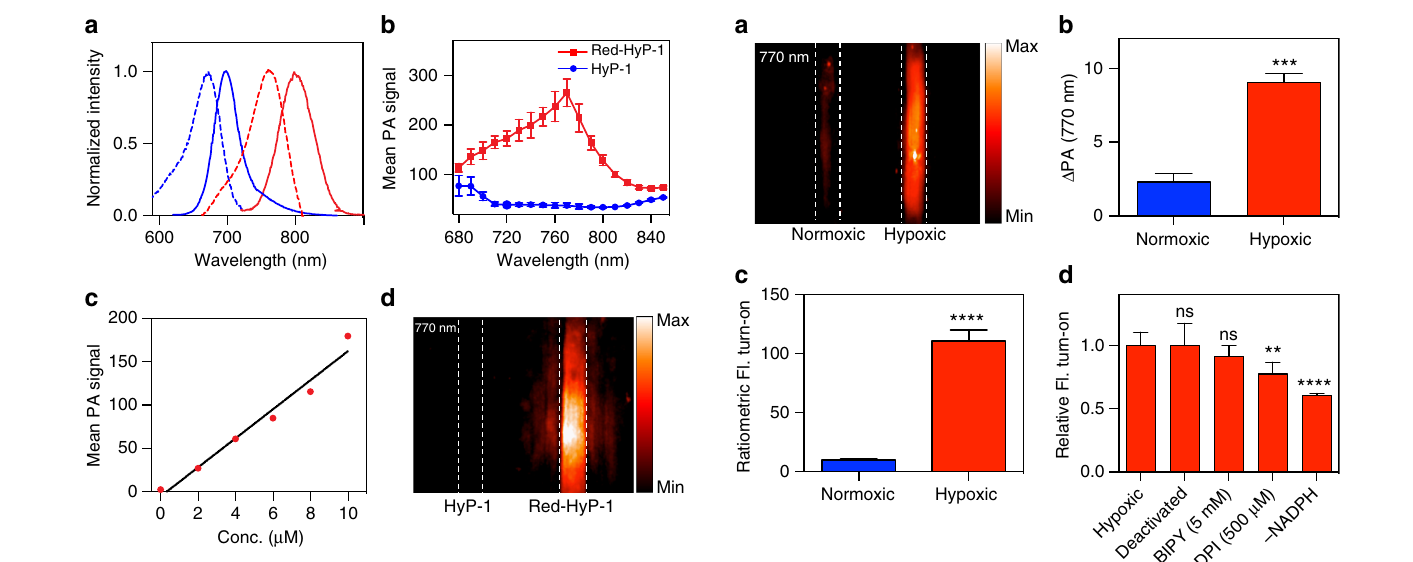
Fig. 4 Hypoxia-selective response of HyP-1 in vitro. a Representative PA image (770 nm) of reaction mixtures incubated under normoxic or hypoxic conditions for 2 h, then quenched with an equal volume of acetonitrile. Dashed lines indicate positioning of FEP tubes. b Change in PA signal (770 nm) produced after 2 h incubation of HyP-1 (10 μ M) with rat liver microsomes (RLM) (200 μ g/mL) and NADPH (50 μ M) in normoxic and hypoxic conditions ( n = 3). c Ratiometric fl uorescence turn-on after 2 h incubation of HyP-1 (2 μ M) with RLM (200 μ g/mL) and NADPH (50 μ M) in normoxic or hypoxic conditions ( n = 3). d Normalized fl uorescent turn-on after 1 h hypoxic incubation of HyP-1 (2 μ M) with RLM (100 μ g/mL) and NADPH (50 μ M) under various conditions. Statistical signi fi cance represents a comparison to the hypoxic control ( n = 6). Results with error bars are represented as mean ± SD. ** p < 0.01, *** p < 0.001,